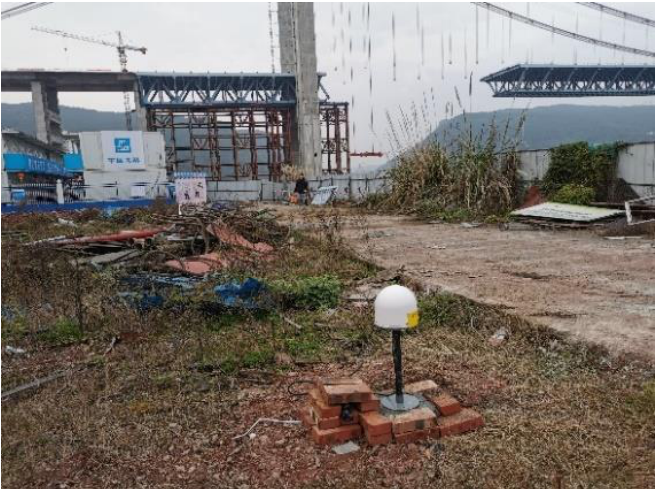
Figure 12. GNSS reference station JIZH.